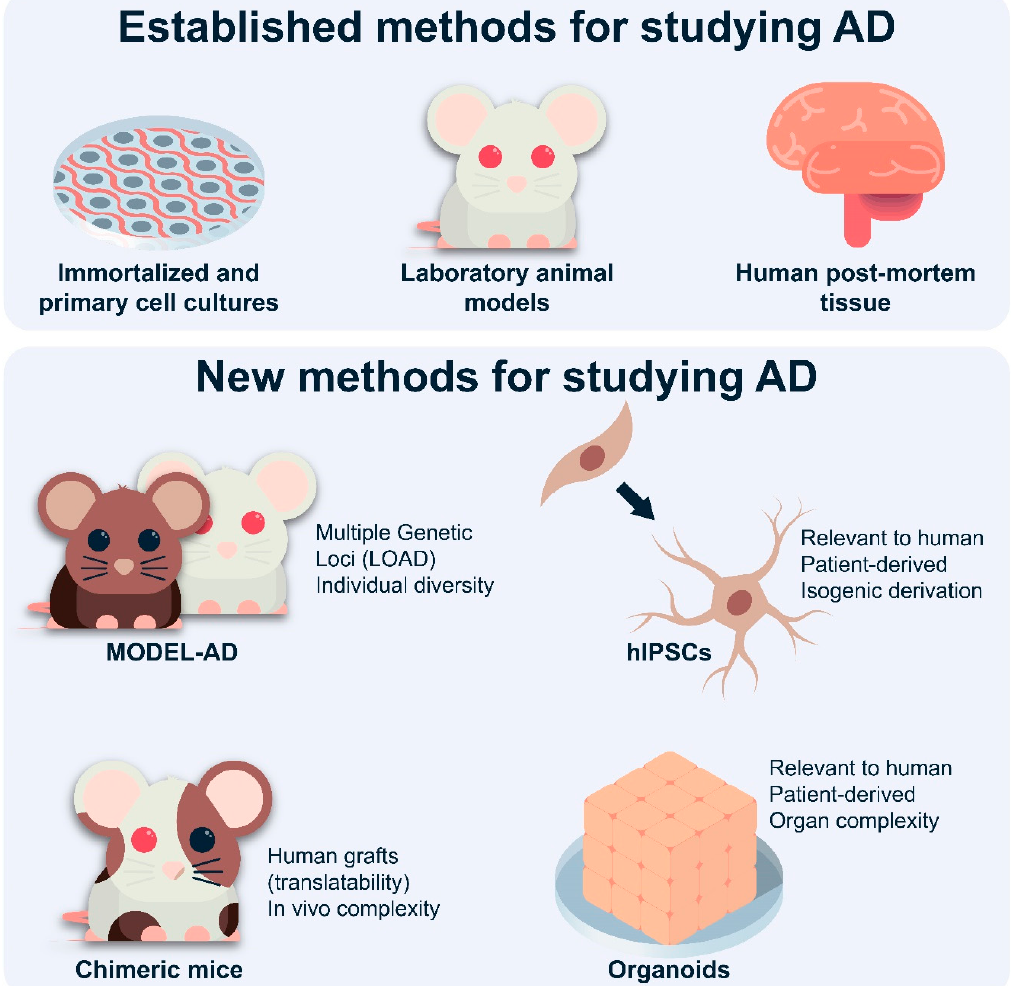
Figure 2. Overview of established and novel methodologies and models used to study Alzheimer’s disease. Top: various in vitro and in vivo models have been generated over the past years and are being used along with human tissue to study AD. Bottom: four new methodologies and models that have been developed in the past few years to improve the translatability and relevance of findings for AD. The MODEL-AD consortium will increase the availability of mouse models carrying di ff erent mutations and will include wild mouse strains that represent the genetic diversity present in human